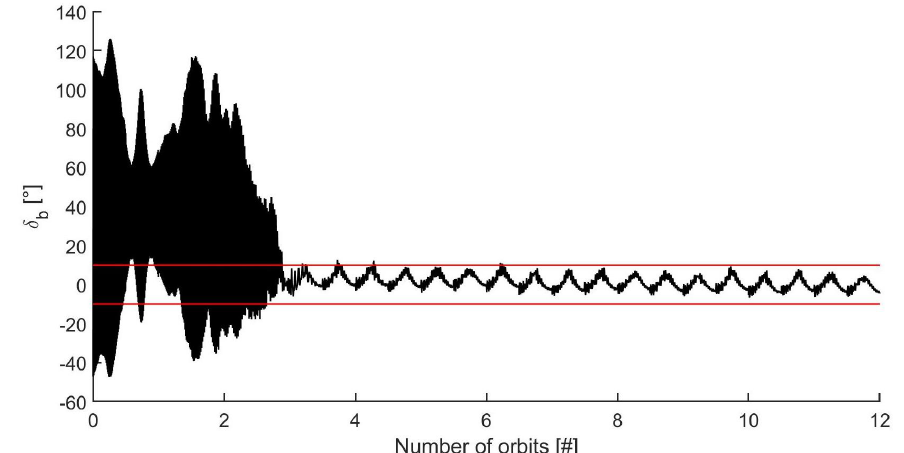
Figure 10. Misalignment error between ˆ z b and B b for PMACS with 4 permanent magnets.